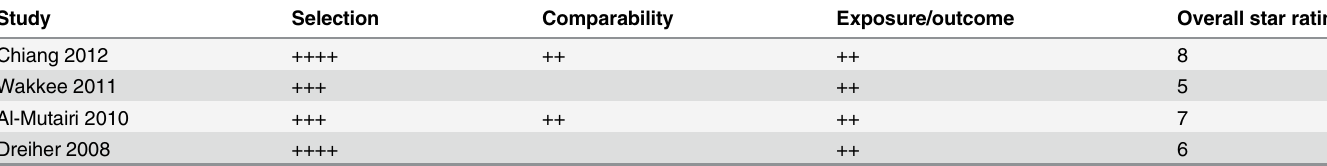
Table 2. Newcastle – Ottawa Scale (NOS) Quality Assessment Table.